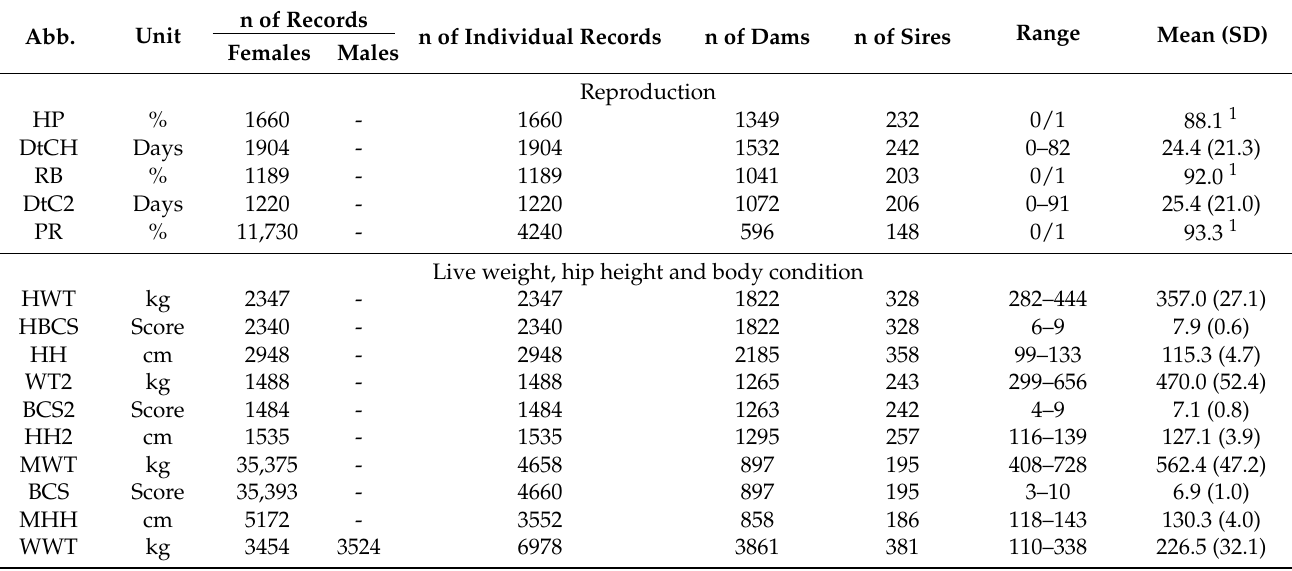
Table 1. Trait abbreviations, units of measurement, number (n) of records, individual animals, sires and dams, range of measurements, means and standard deviations (SD) after adjustments and scaling.